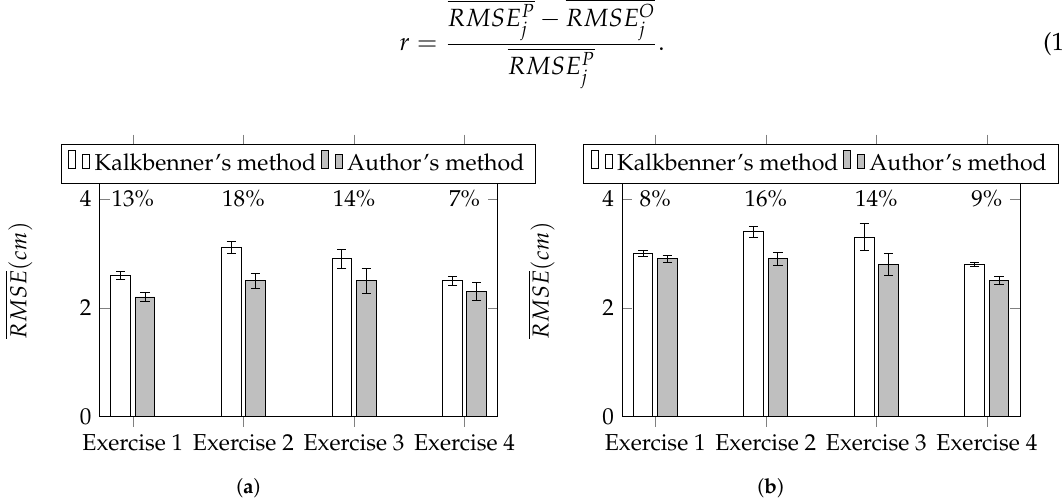
Figure 17. Average root square mean error RMSE of the elbow ( a ) and the wrist ( b ) joint position estimation.